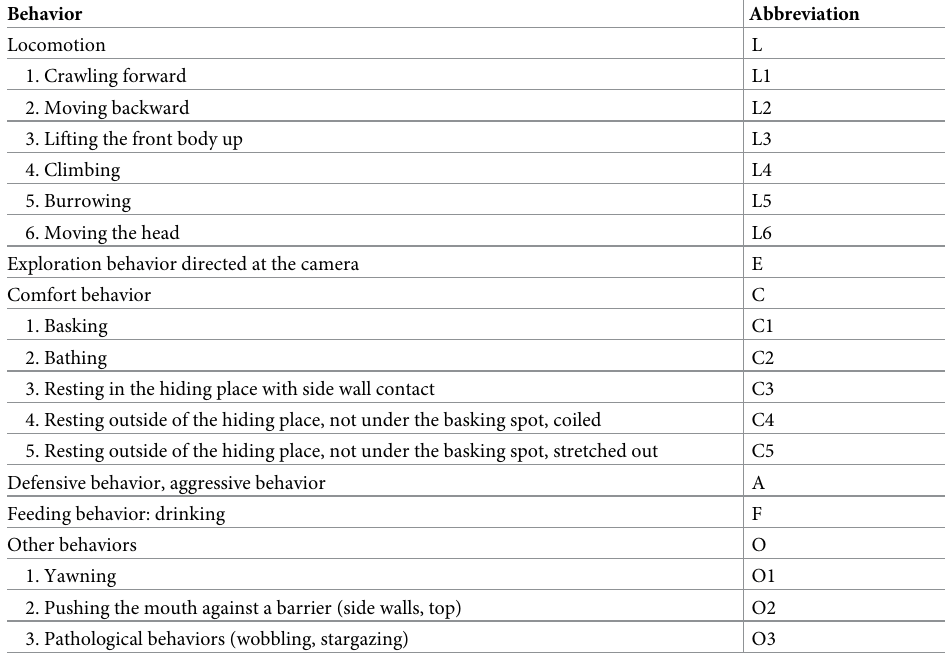
Table 2. Ethogram for the ball python.